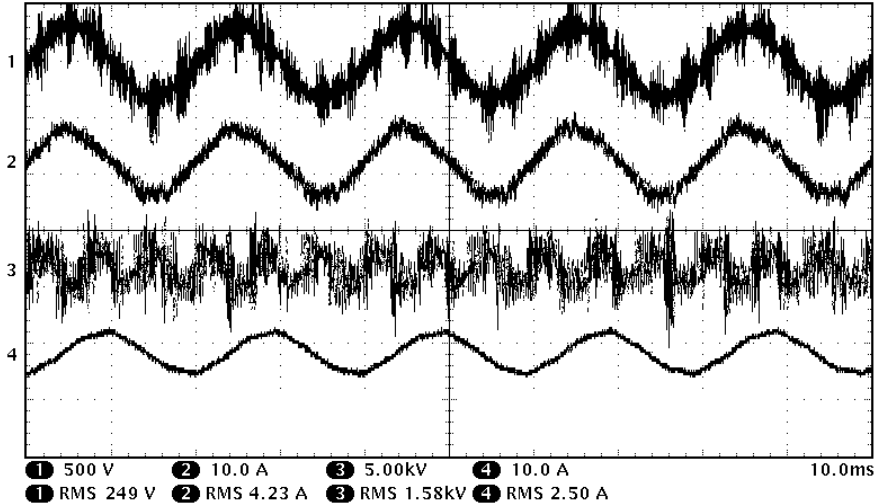
Figure 11. Current and voltage waveforms of PCS power supply, 1 — input voltage, 2 — input current, 3 — output voltage, 4 — output current, plasma gas: argon, flow: 2.8 m 3 /h.